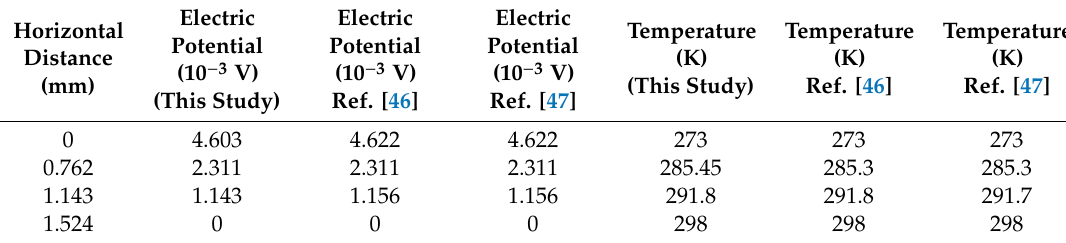
Table 4. Comparison between the PD result and the results from references [46,47] in the case of constant material properties.